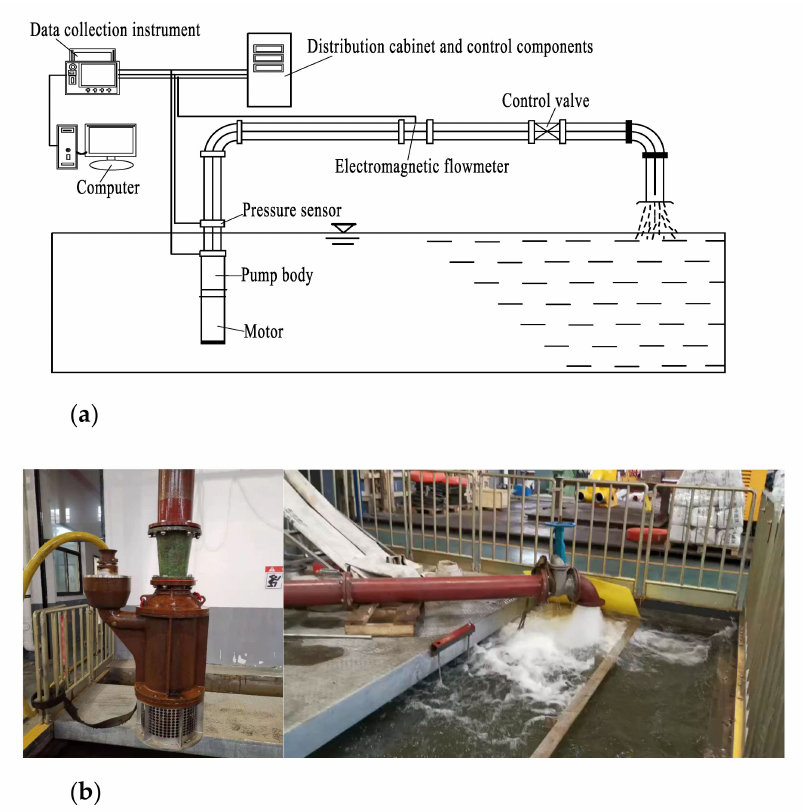
Figure 8. Experimental measurement. ( a ) The schematic diagram of the pump test. ( b ) The test site